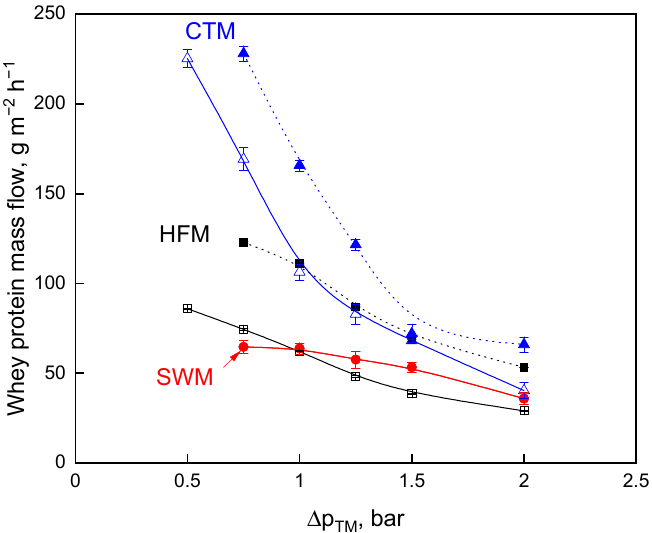
Figure 4. Mass flow of whey proteins as a function of transmembrane pressure, ∆ p TM , for skim milk microfiltration for spiral wound membrane (SWM; • ), ceramic tubular membrane (CTM; △ τ w = 76 Pa; ▲ τ w = 127 Pa), and hollow fi ber membrane (HFM; □ τ w = 23 Pa; ■ τ w = 48 Pa).